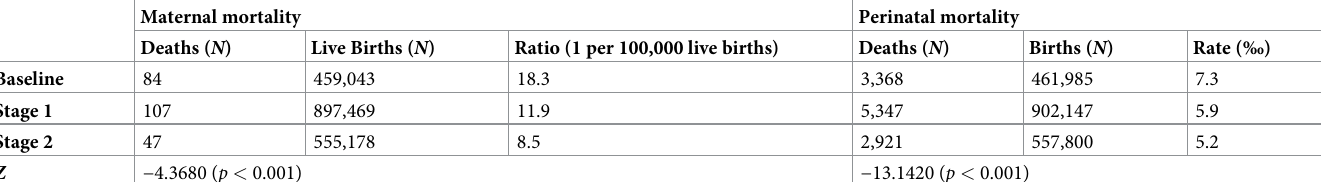
Table 3. MMR and PMR by intervention stages in Guangzhou, China,